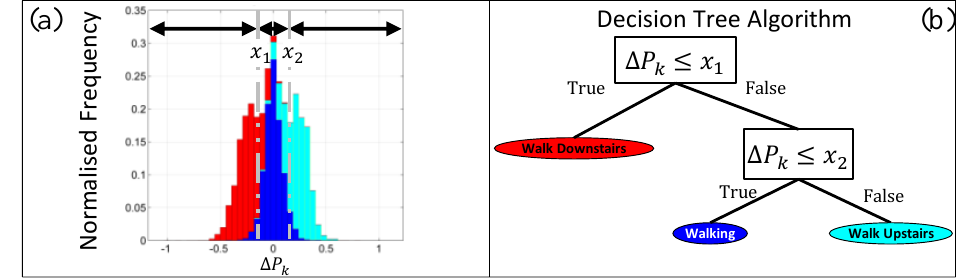
Figure 5. ( a ) Normalized frequency histogram for the ∆ P k feature and three activity classes (walk downstairs (in red), walking (in blue), and walk upstairs (in light blue), visualized as stacked bars); ( b ) An example of the decision tree, used at each node of the HMHA; i.e., the blue rectangles in Figure 4. x and x , are derived from Figure 5a according to the classification and regression tree 2 1